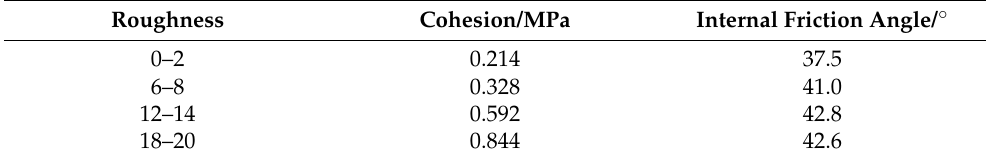
Table 1. Mechanical parameters of joint.